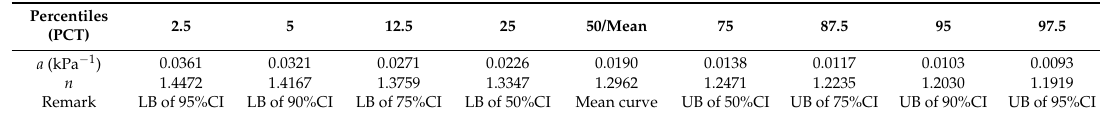
Figure 7. Confidence intervals of the SWCC. Table 2. Model parameters of the SWCC for different percentiles.